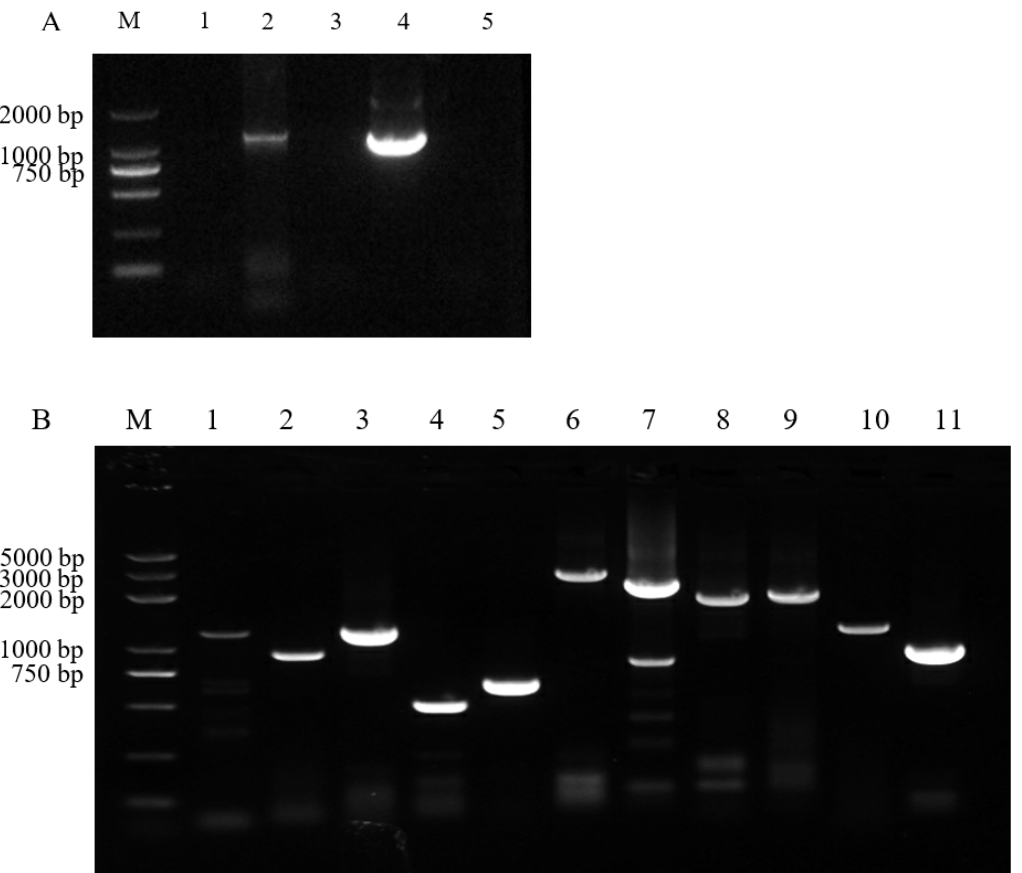
Figure 1. Characterization of RVC infection in collected pig samples. ( A ) RVC PCR amplification of collected samples. M: DL marker 2000; lanes 1–3: collected samples; lane 4: RVC VP6 plasmid; lane 5: negative control. ( B ) Whole-genome amplification of RVC/Pig/China/JS02/2018/G6P6. M: DL2000 plus; lane 1: NSP1; lane 2: NSP2; lane 3: NSP3; lane 4: NSP4; lane 5: NSP5; lane 6: VP1; lane 7: VP2; lane 8: VP3; lane 9: VP4; lane 10: VP6; lane 11: VP7. 1. Nucleotide and amino acid identities of genome segments of strains RVC/Pig/CHN/JS02/2018/G6P6 compared with the closest strains from GenBank